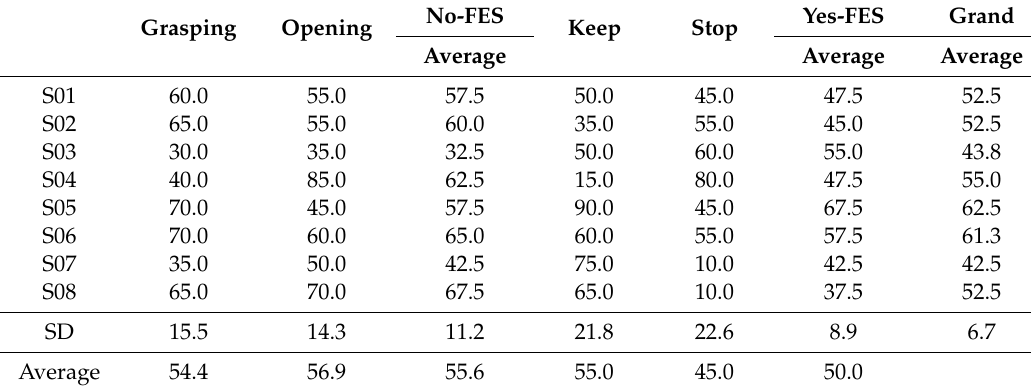
Table 4. Accuracy of each task